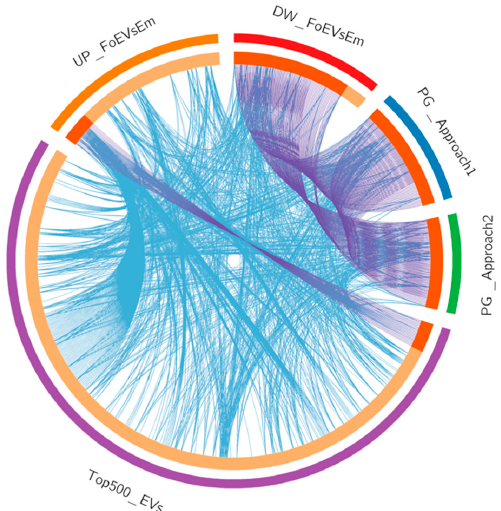
Figure 7. Meta-enrichment analysis summary for list of identified and potential target genes in embryos regulated by miRNAs in oEVs. Input lists: (1) the top 500 mRNAs in oEVs (Top500_EVs, Purple); (2) the upregulated genes in FoEV-treated versus Co embryos (UP_FoEVsEmb, Orange); (3) the downregulated genes in FoEV-treated versus Co embryos (DW_FoEVsEmb, Red); (4) the potential genes targeted by miRNAs contained in oEVs based on Approach 1 from identified downregulated genes (PG_miRNAs_Evs_T1, Blue); and (5) based on Approach 2 from identified miRNAs in oEVs (PG_miRNAs_Evs_T2, Green). Circular plot representing overlaps among gene lists at the gene level, where purple lines link identical genes and blue lines link genes belonging to the same enriched ontology term. The inner circle represents gene lists, where hits are arranged along the arc. Genes hit multiple lists are colored in dark orange, and genes unique to a list are shown in light orange.